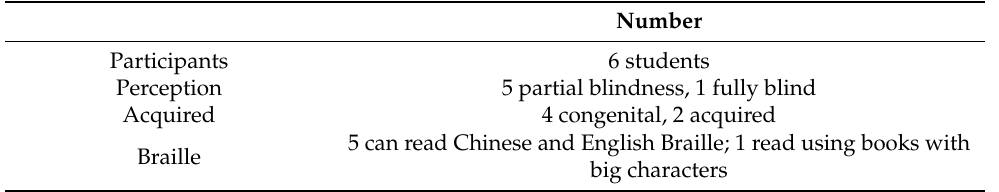
Table 3. Demographics of the